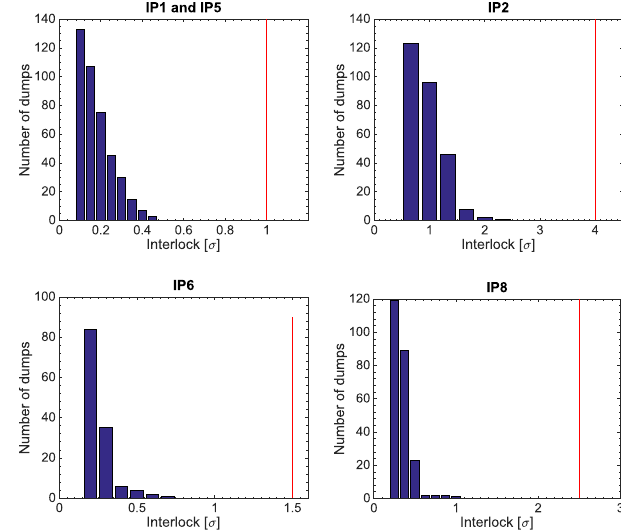
FIG. 22. Number of predicted dumps during stable beams for different BPM interlock thresholds for TCTP and TCSP colli- mators separated by IR configuration in nominal beam σ . The red line indicates the proposed threshold for each configuration.